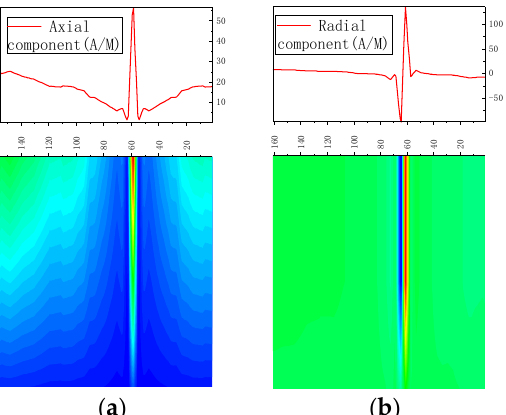
Figure 6. Crack magnetic signal of pipe base material. ( a ) Axial component of weak magnetic signal; ( b ) radial component of weak magnetic signal.